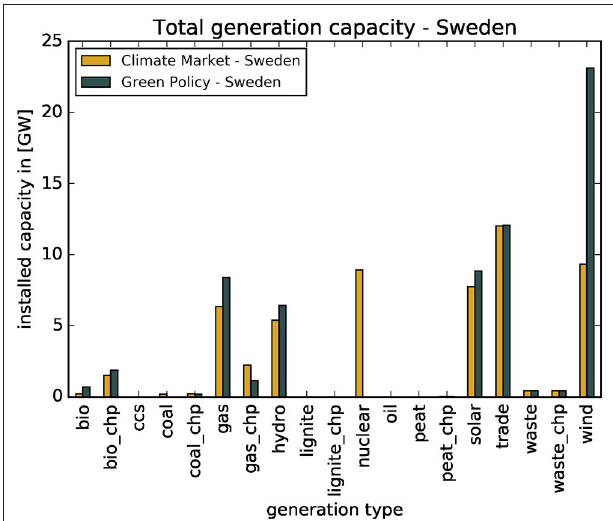
FIGURE 3 | Generation capacities for Sweden according to output from the ELIN investment model for Year 2032. The PV capacity from the household annual cost optimization model, which residential prosumers invest in, has been added to the 0.9 GW of PV capacity from the ELIN model under the label “solar”.